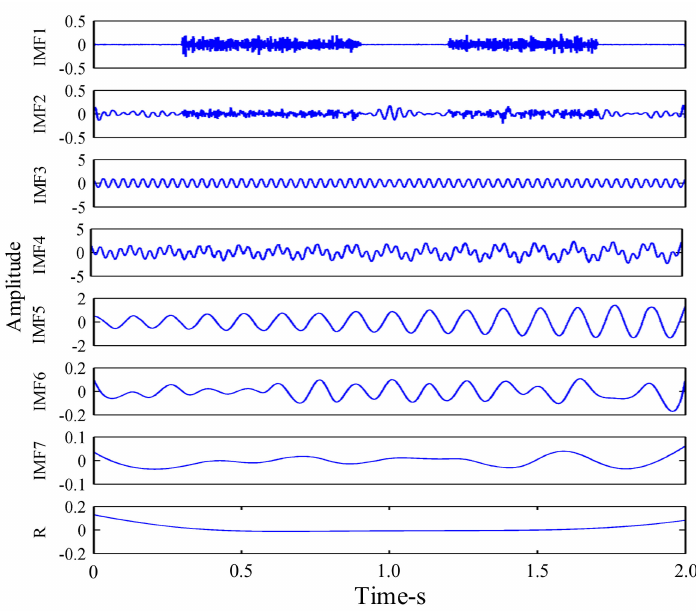
Figure 7. Ensemble empirical mode decomposition (EEMD) decomposition of the synthesized signal. The amplitude of the added Gaussian white noise was a l = 0.2, and the total number of noises added was N e = 100. The results obtained by EEMD decomposition of the signal are shown in Figure 7. It can be seen, from Figure 7, that EEMD decomposed many pseudo-components. After EEMD decomposition of the simulation signal x ( t ), seven IMF components and one residual component were decomposed, among which IMF3 and IMF5, respectively, represent the sine signal x 1 ( t ) and the amplitude modulation signal x 2 ( t ) in the synthetic simulation signal x ( t ). The simulation signal x ( t ) was also decomposed by MEEMD, as shown in Figure 8. It can be seen, from Figure 3, that three IMF components and one residual component were decomposed, among which IMF2 and IMF3, respectively, represent x 1 ( t ) and x 2 ( t ) in the synthetic simulation signal x ( t ). Compared with EEMD, MEEMD can effectively eliminate the